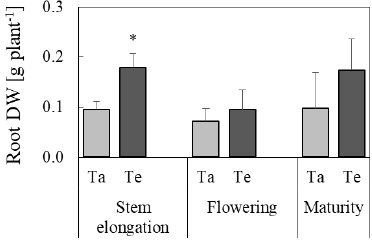
Fig. 5: Effects of elevated temperature (T e , dark grey) compared to ambient temperature conditions (T a , light grey) on root dry weight (DW) of barley. Harvests were done at stem elongation, flowering, and plant maturity. Means and SDs are shown, asterisk indicates significance (*P ≤ 0.05, tested by a mixed-effects model); n =